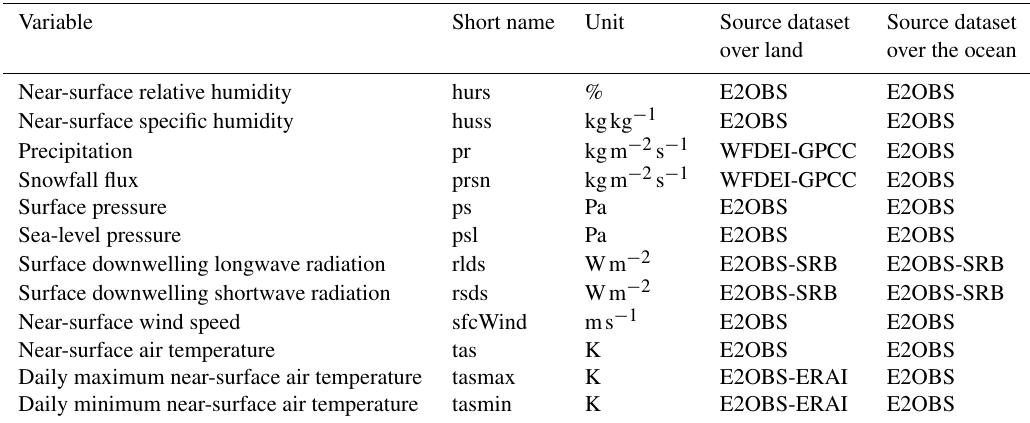
Table 1. Data sources of individual variables of the EWEMBI dataset (Lange, 2016). Note that E2OBS data are identical to WFDEI over land and ERAI over the ocean, except for precipitation over the ocean, which was bias-adjusted using GPCPv2.1 monthly precipitation totals (Balsamo et al., 2015; Dutra, 2015). WFDEI-GPCC means WFDEI with GPCCv5 and v6 monthly precipitation totals used for bias adjustment (Weedon et al., 2014; note that the WFDEI precipitation products included in E2OBS were those that were bias-adjusted with CRU TS3.101/TS3.21 monthly precipitation totals). E2OBS-SRB means E2OBS with SRB daily mean radiation used for bias adjustment (Lange, 2017). E2OBS-ERAI means E2OBS everywhere except over Greenland and Iceland (see Weedon et al., 2010, p. 9), where monthly mean diurnal temperature ranges were restored to those of ERAI using the Sheffield et al. (2006) method. Note that precipitation here means total precipitation, i.e. rainfall plus